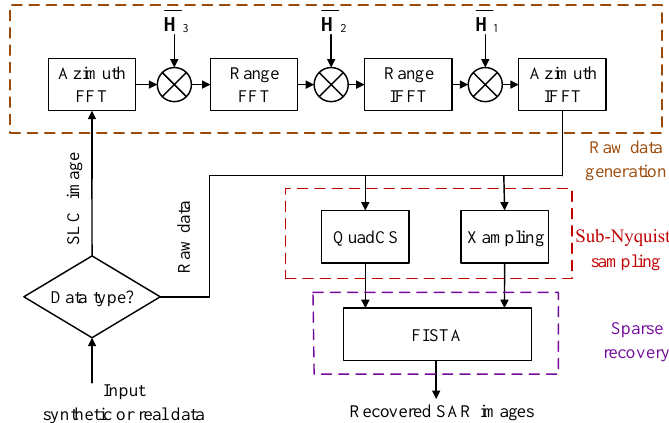
Figure 3. Block diagram of simulations. We take synthetic, real images and real raw data as input data, respectively. The simulated data output by QuadCS and Xampling are processed by a sparse recovery